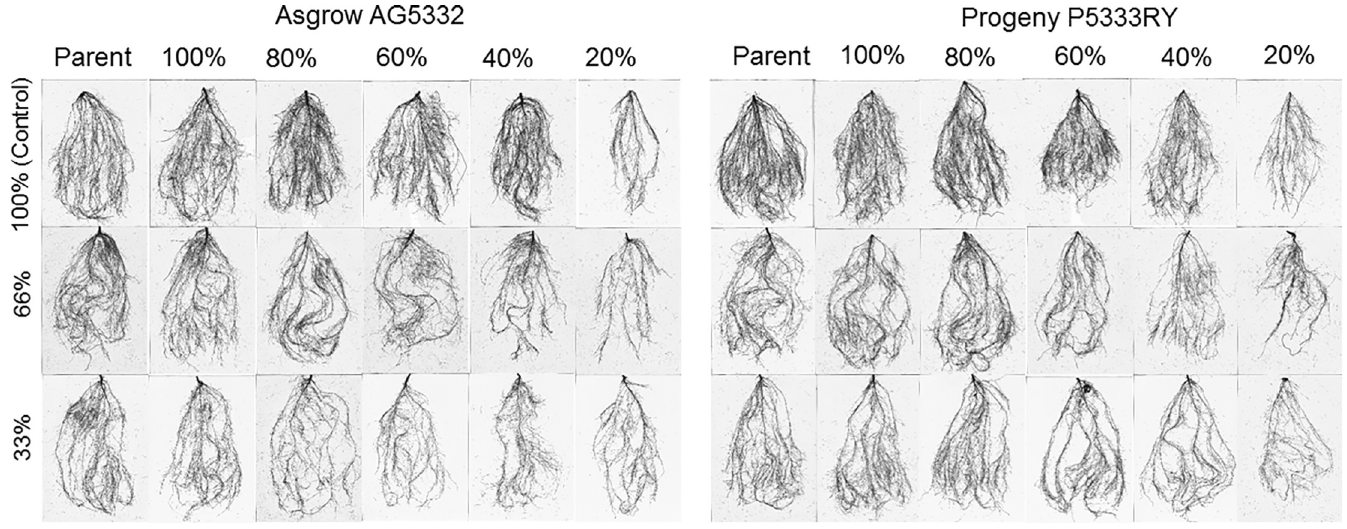
Fig 7. Root growth for the F1 generation of soybean cultivar Asgrow AG5332 and Progeny P5333RY exposed to drought stress, including replacement of 100, 80, 60, 40, and 20% of the evapotranspiration demand.